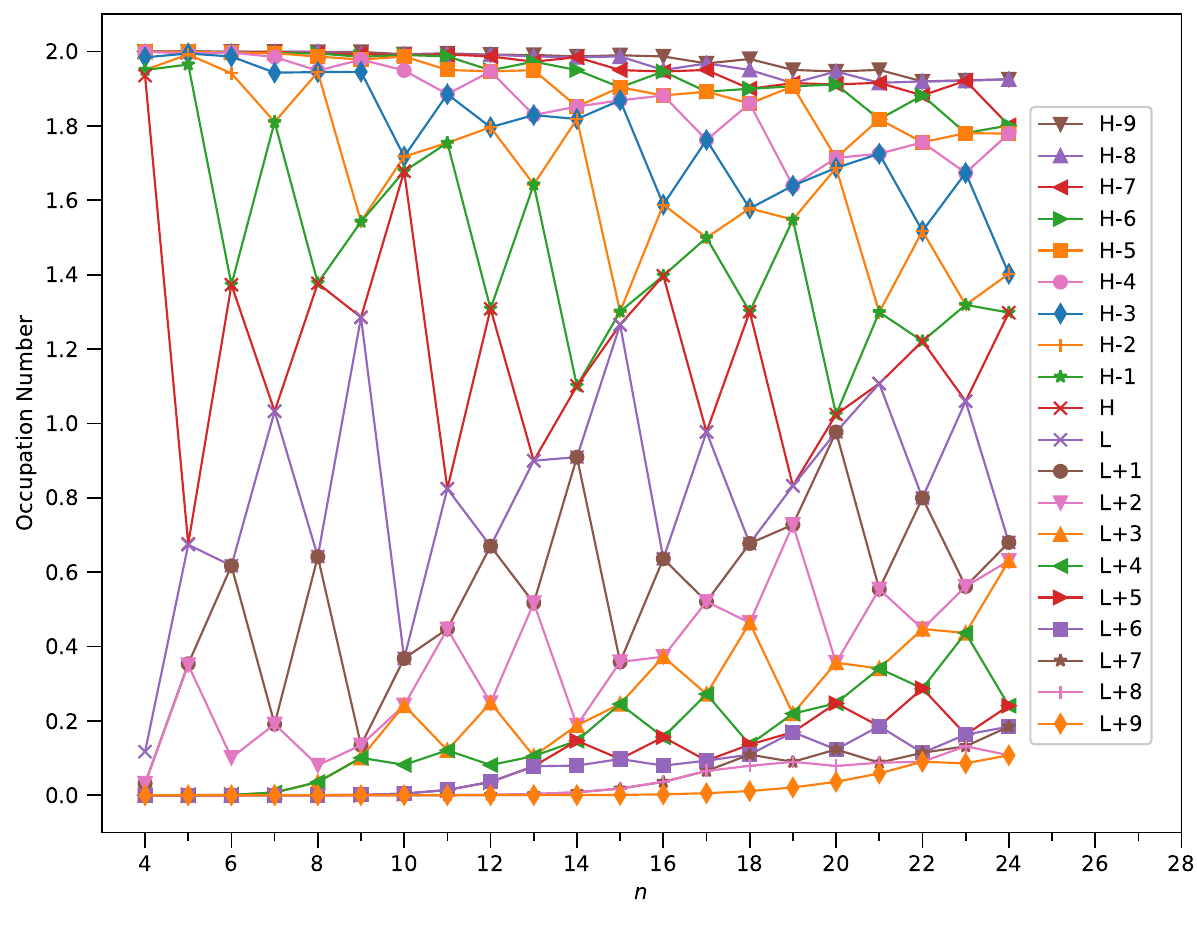
Figure 7. Occupation numbers of active TAO-orbitals (H − 9, H − 8, ..., H − 1, H, L, L+1, ..., L + 8, and L + 9) of ground-state C-Belt[ n ], computed using spin-restricted